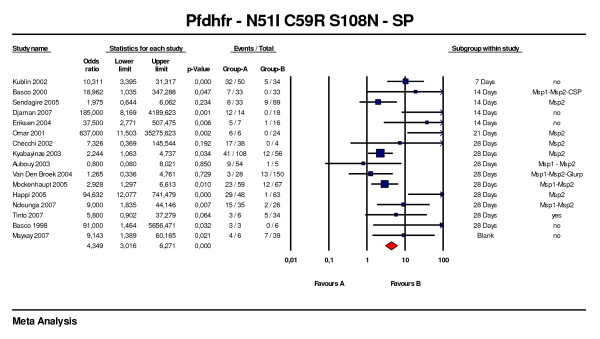
Pfdhfr N51I+C59R+S108N predictive value of therapeutic failure with Sulfadoxine-pyrimethamine. Studies with different follow-up were included. The duration of the follow-up of the last study was supposed to be 28 days while not clearly indicated in the method by authors.